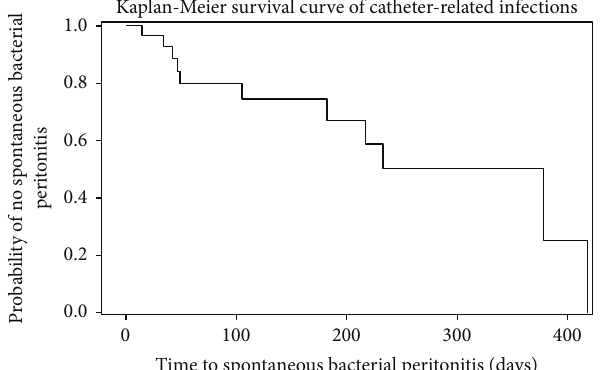
Figure 1: Kaplan-Meier curve displaying the interval between drain insertion and spontaneous bacterial peritonitis secondary to microorganisms consistent with skin flora (i.e., Staphylococcus , Pseudomonas , Bacillus species, Coryneform , and Acinetobacter